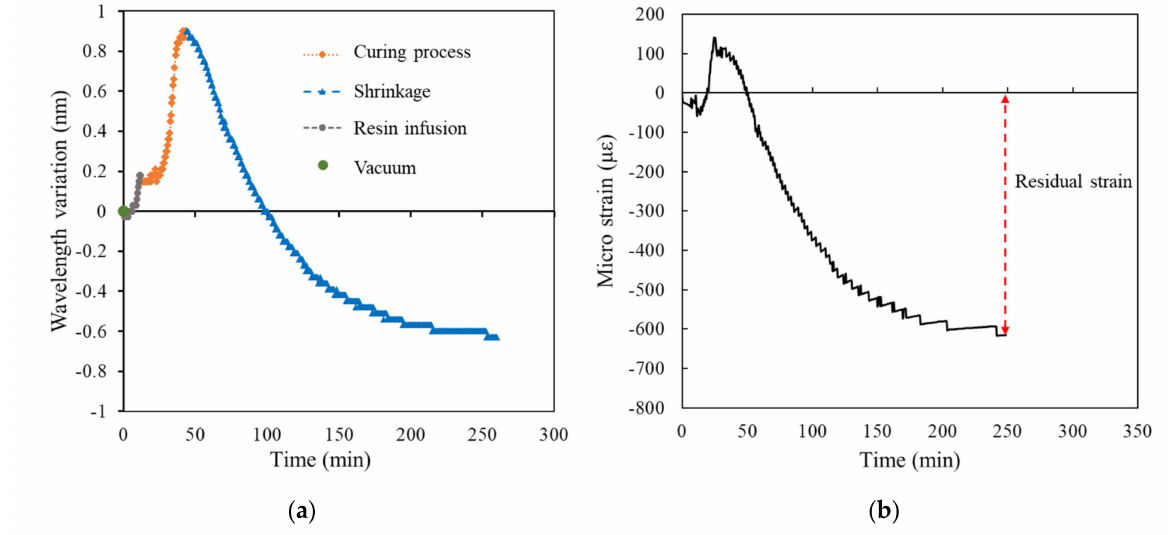
Figure 12. Experimental results of surface laminate-stacking number is 30. ( a ) Wavelength-variation varying with time. ( b ) Residual strain.